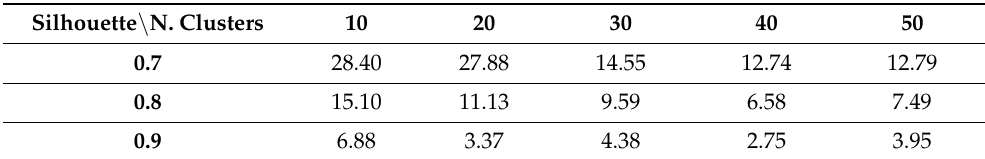
Table 48. Clustering performance in terms of silhouettes using the reduced dataset with SPQR applied to normalized data.